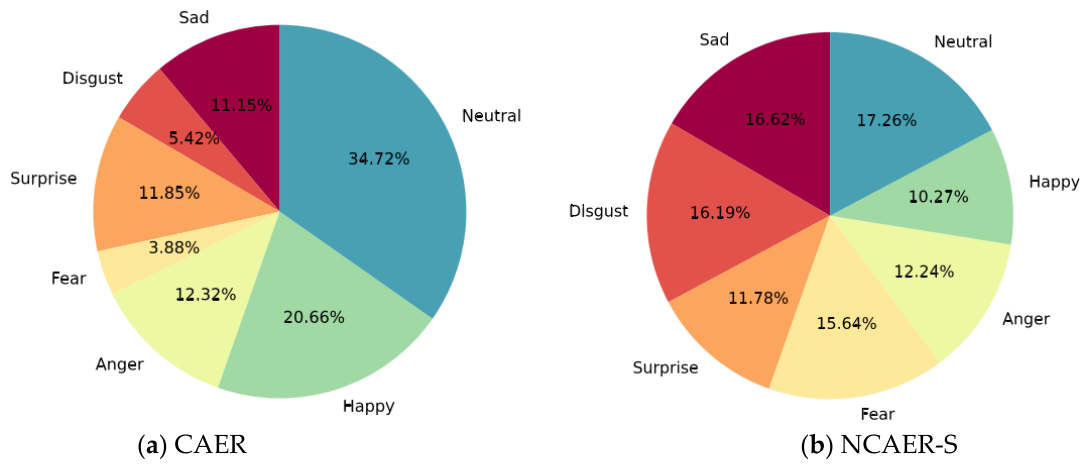
Figure 6. Percentage of each emotion category in CAER and NCAER-S training sets.